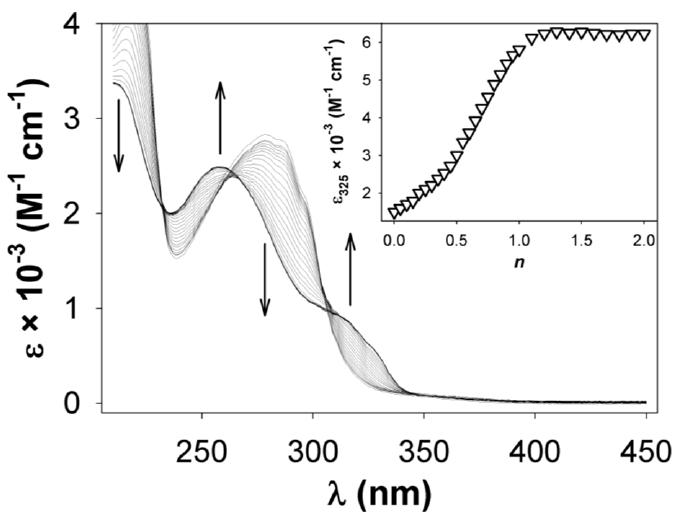
Figure 5. Absorption spectra recorded during the titration of an MeCN solution of 9a (10 − 5 M) with zinc(II) ion. In the inset, the titration profile shows the formation of a 1:1 adduct ( n = equiv. of Zn II ion/equiv. of 9a ).